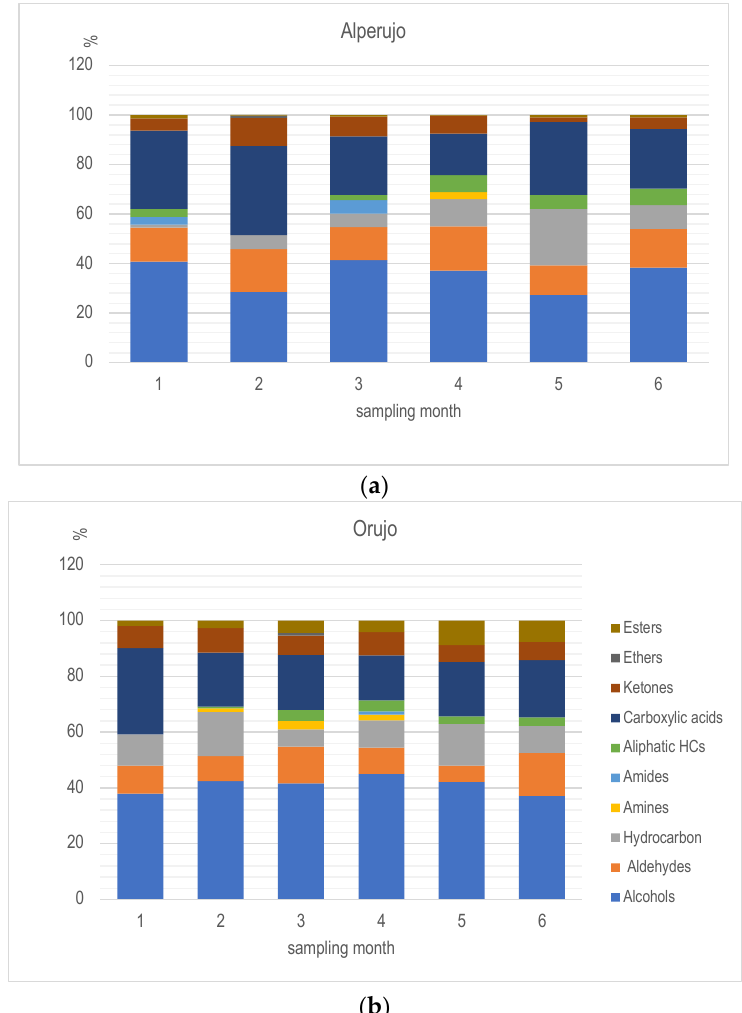
Figure 2. Percentage distribution of VOCs by family in ( a ) alperujo and ( b ) orujo in the six-month experimentation period.